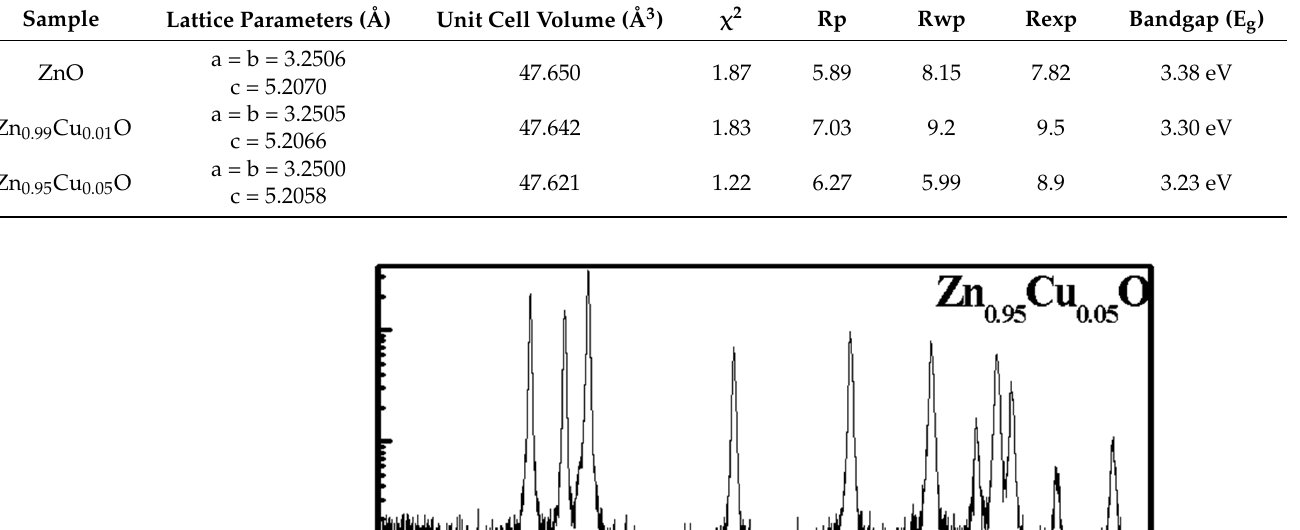
Table 1. Various structural parameters obtained from the Rietveld refinement and bandgap en- ergy of Cu-doped ZnO nanostructures.